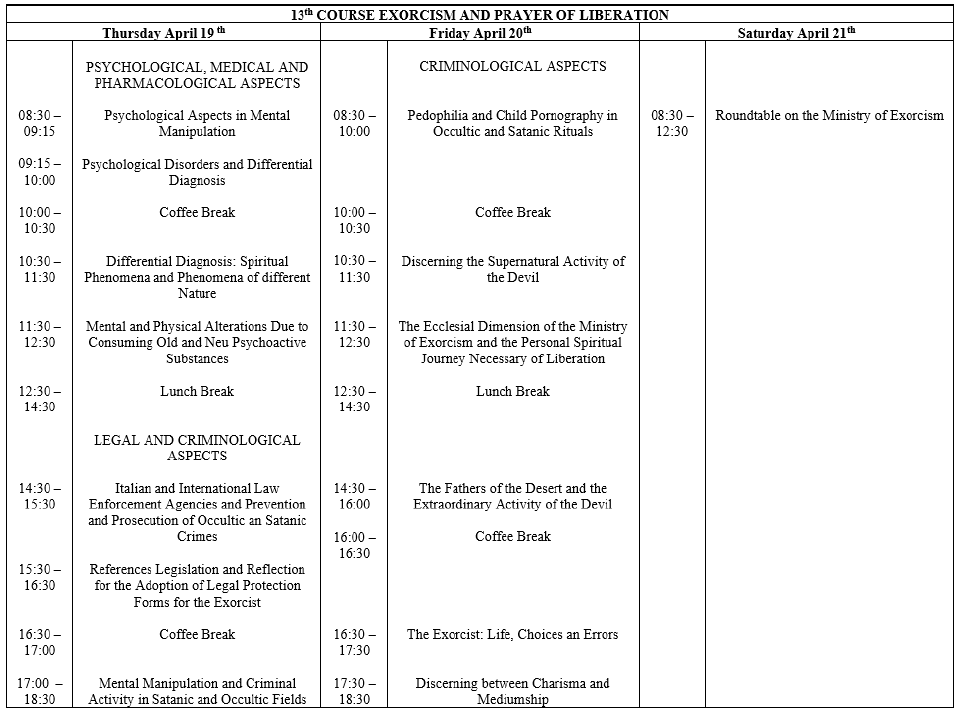
Figure 1. Program of the 13th Course on Exorcism and Prayer of